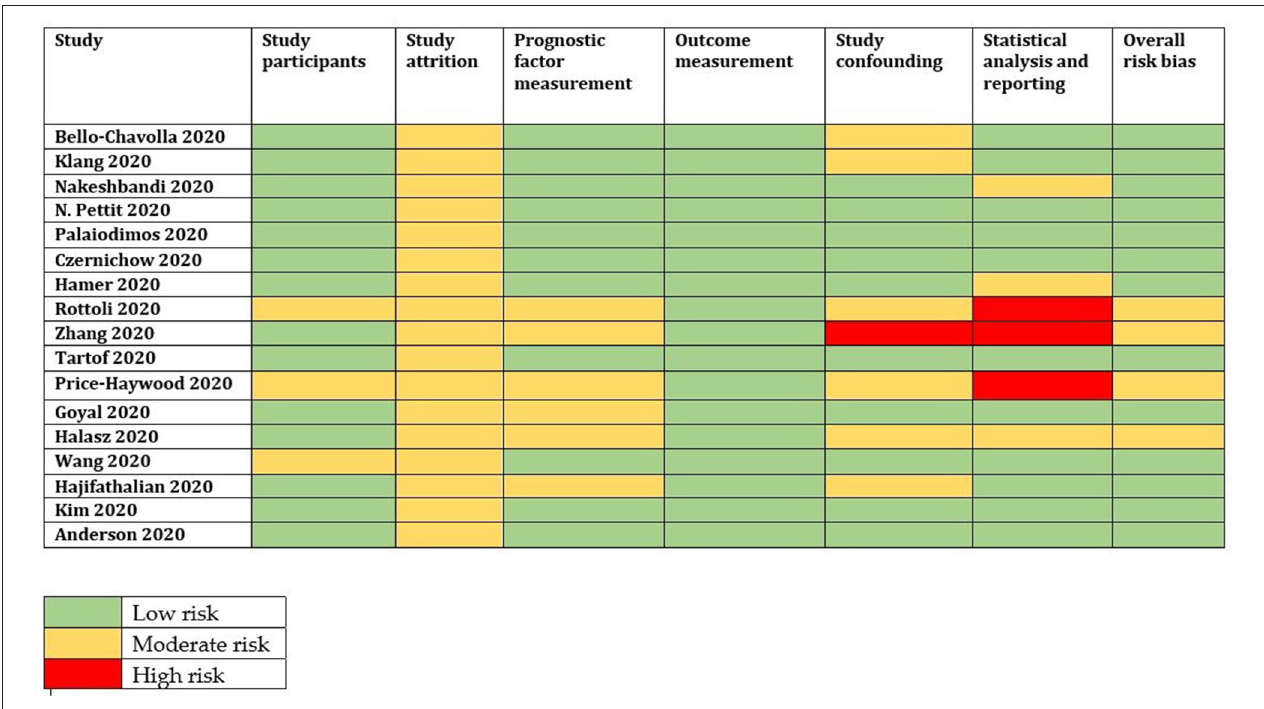
FIGURE 2 | Risk of bias according to the QUIPS tool.